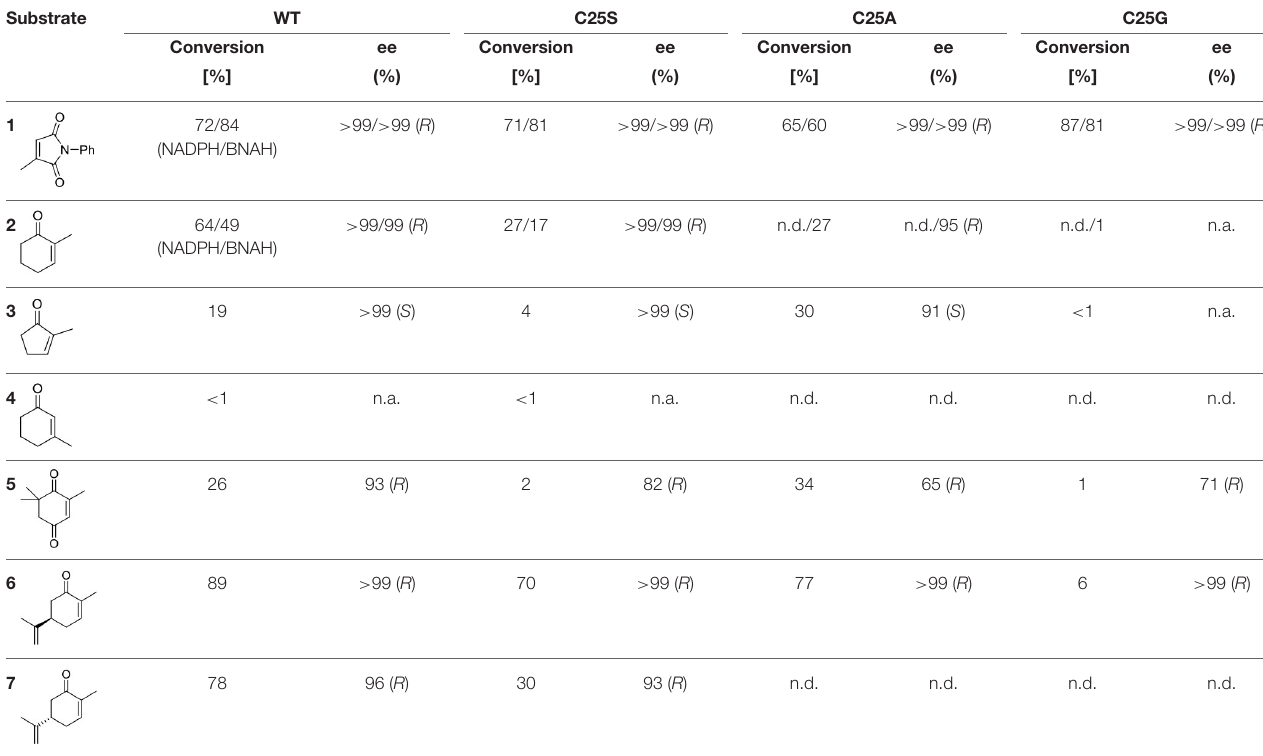
TABLE 4 | Conversion and stereochemistry of OYERo2a (WT) and Cys variants with α , β -unsaturated alkenes. Substrate WT C25S